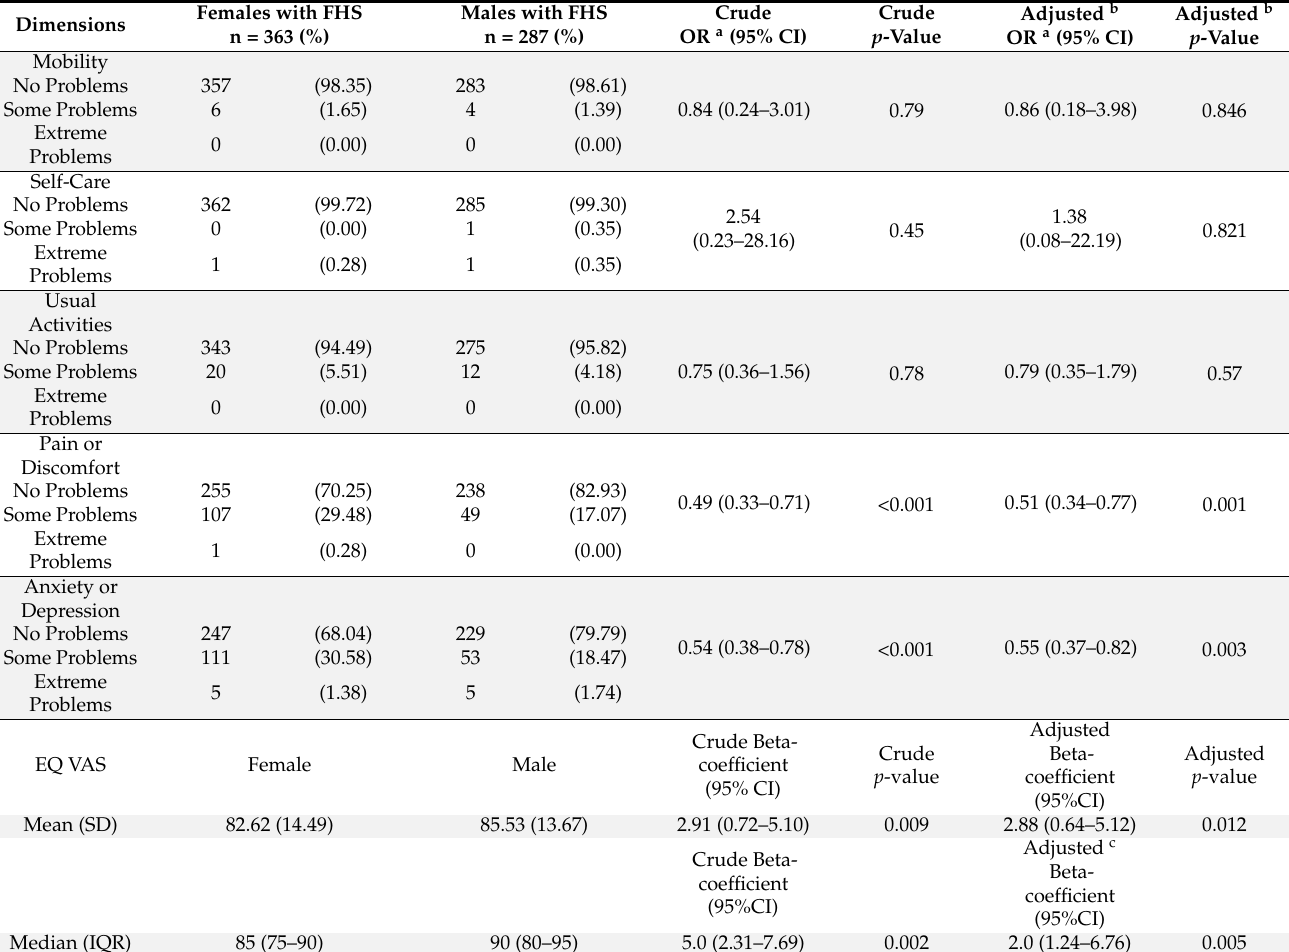
Table 2. Distribution of EQ-5D among adolescents with food hypersensitivity (FHS) in relation to sex. Dimensions